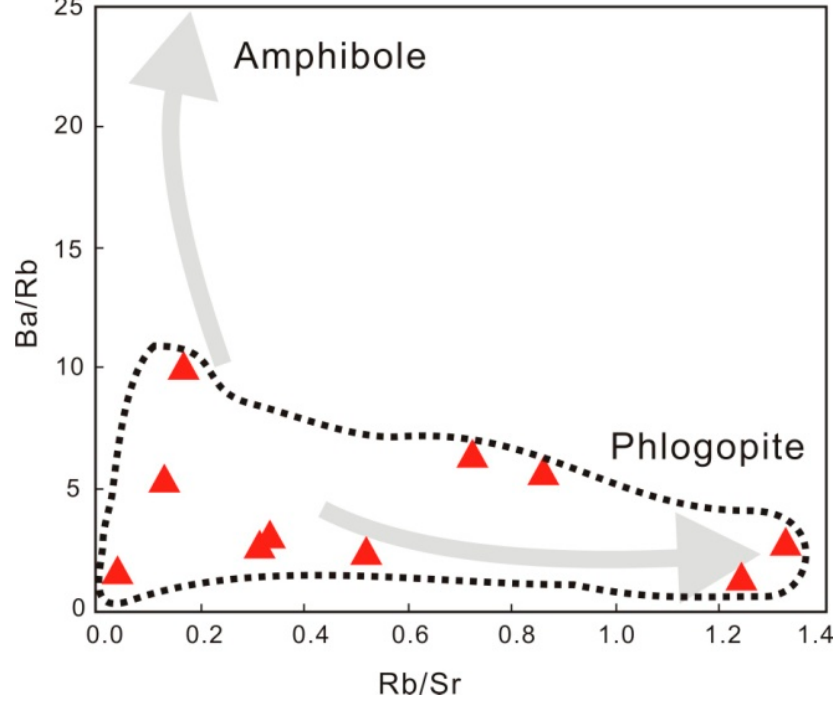
Figure 14. Ba/Rb–Rb/Sr plot of syenite in Bailinchuan district. Low Ba/Rb and high Rb/Sr indicate a major role of phlogopite in the mantle source.